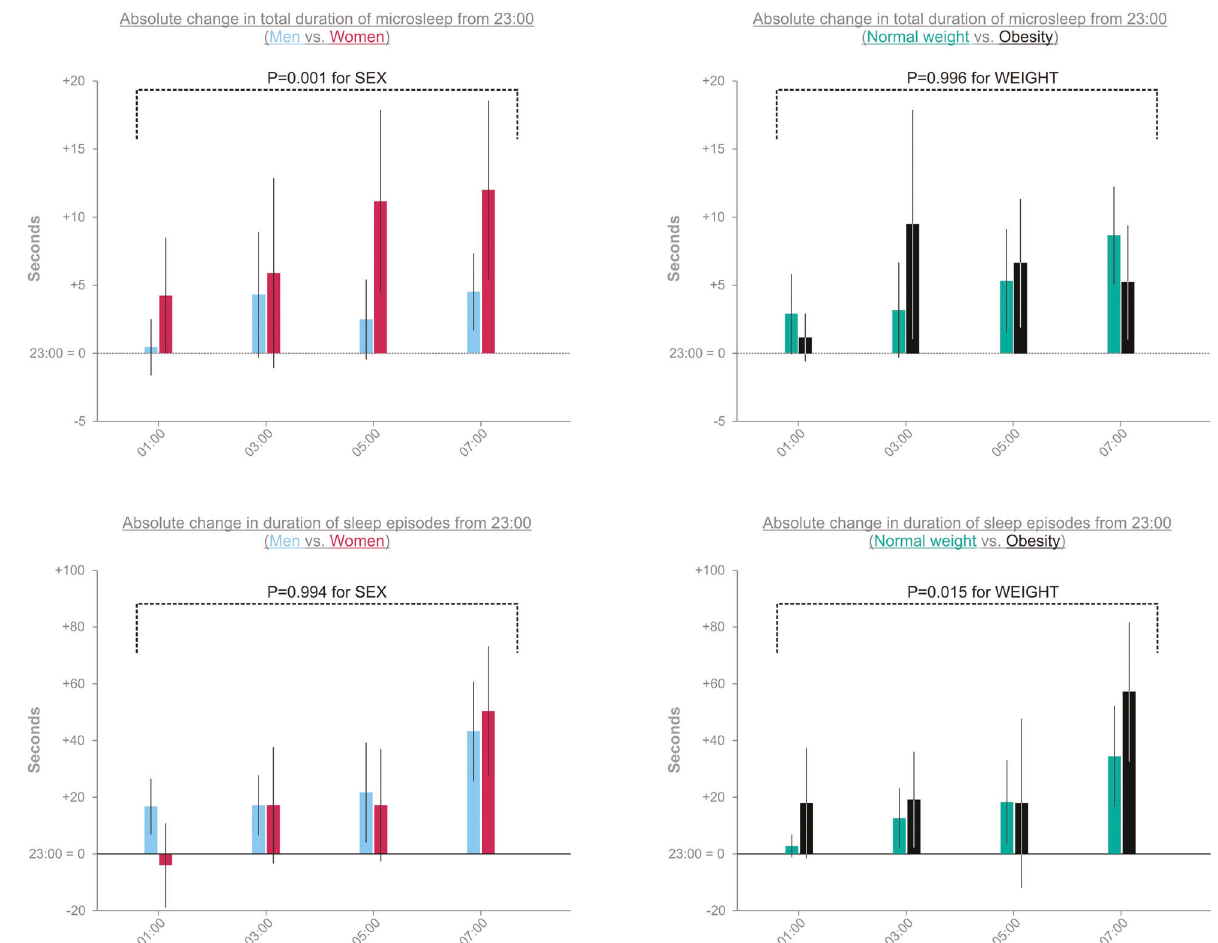
women: 0.3 s ± 1.4 s s; with normal weight: 0.8 s ± 2.5 s; and with obesity: 0.2 s ± 0.7 s. Total duration of sleep episodes at baseline (mean ± SD): men, 8.8 s ± 25.7 s; women: 11.1 s ± 28.7 s; with normal weight: 4.8 s ± 18.7 s; and with obesity: 16.3 s ± 34.0 s. P < 0.05 was considered signi fi